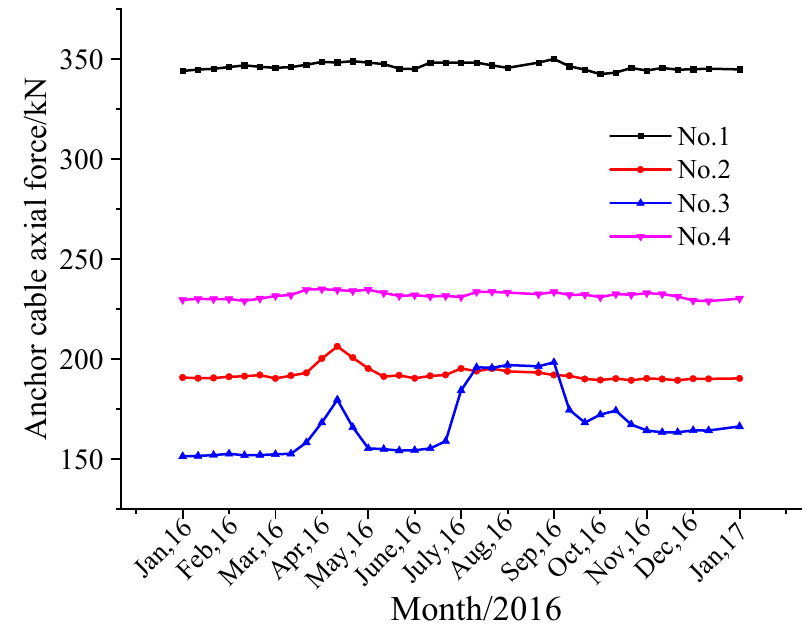
Figure 5. Axial force variation of anchor cable for the north end slope in 2016.